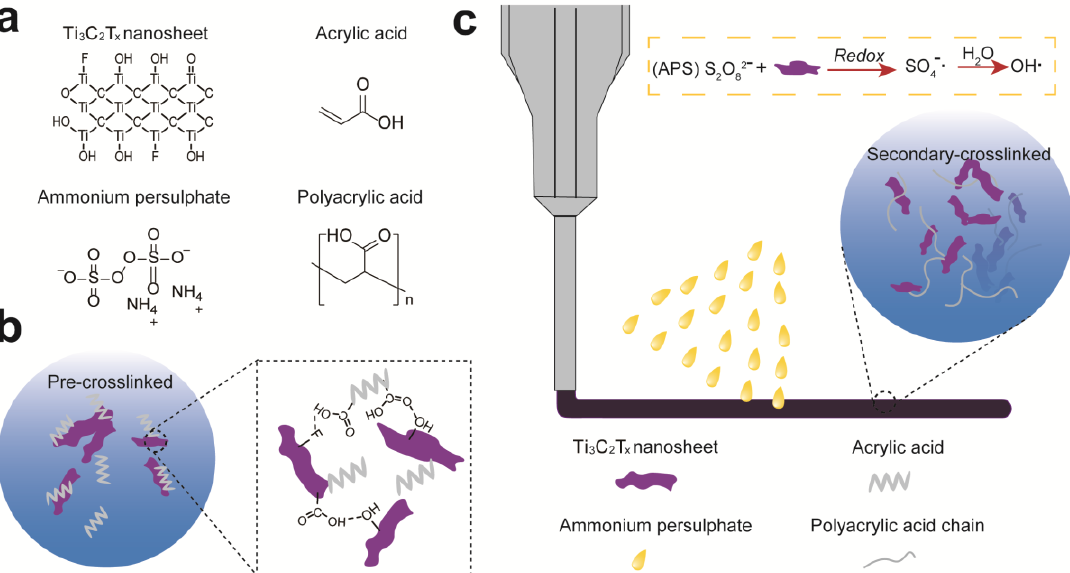
Figure 1. Schematic illustration for preparing Ti 3 C 2 T x -PAA hydrogels via 3D printing. ( a ) Chemical structures of Ti 3 C 2 T x nanosheets, AA, APS, and PAA. ( b ) Pre-polymerization of AA with Ti 3 C 2 T x nanosheets. ( c ) 3D printing and secondary-crosslinking of Ti 3 C 2 T x -PAA hydrogels with APS.